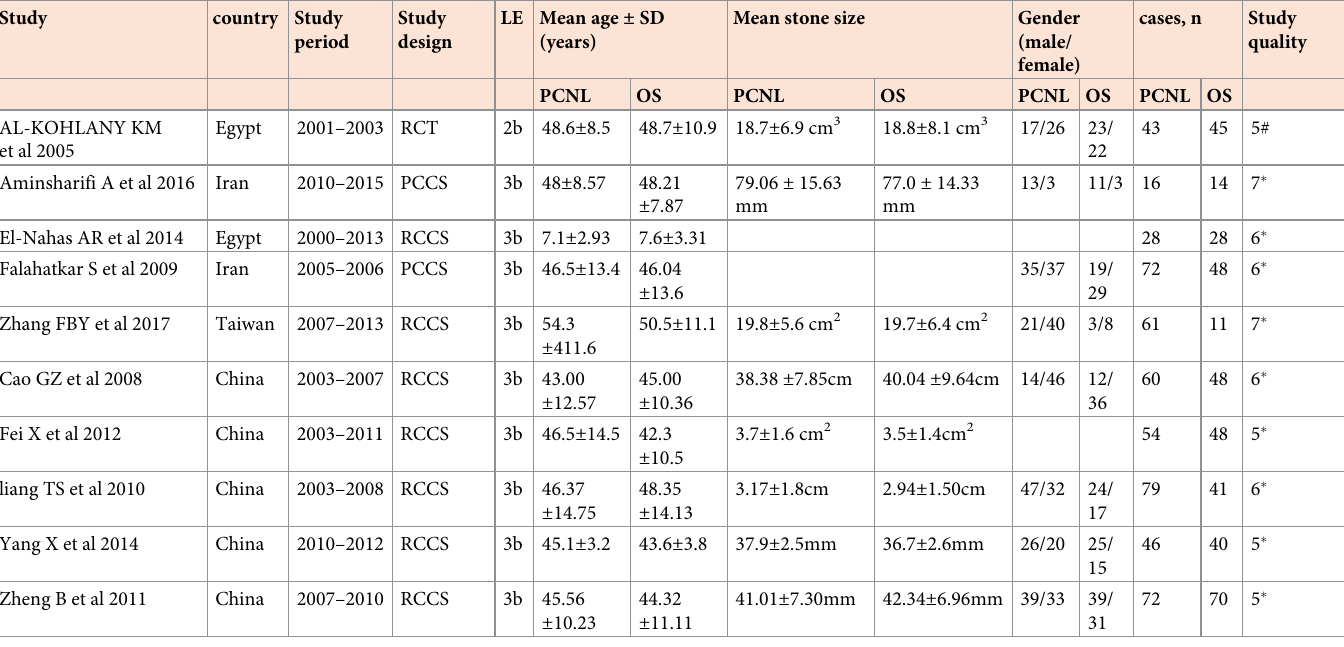
Table 1. The baseline characteristics and quality assessment of all included studies.